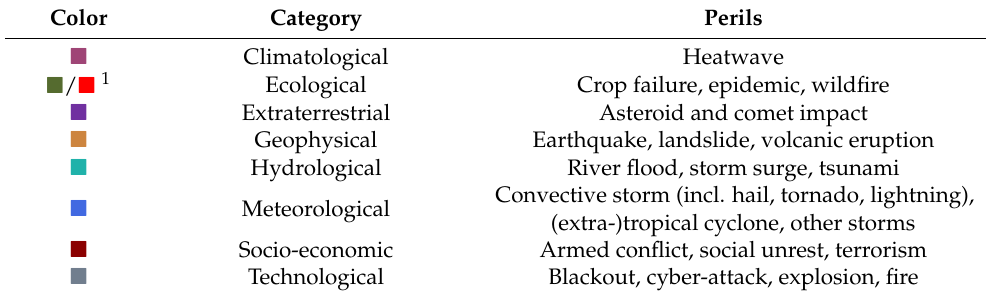
Table A2. Color scheme per peril